Question: In one sentence, what is this figure communicating?
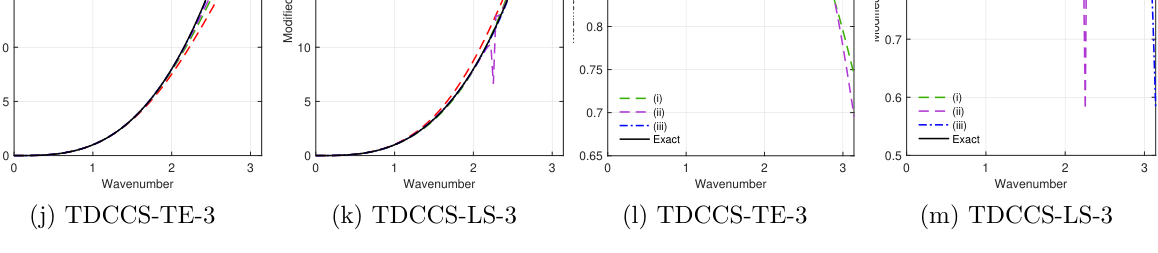
Answer: Plot of modified wavenumber versus wavenumber for (a) TDCCS-TE-1, (b) TDCCS-LS-1, (e) TDCCS-TE-2, (f) TDCCS-LS-2, (j) TDCCS-TE-3 and (k) TDCCS-LS-3: (i) T4; (ii) T6; (iii) T8; (iv) P10. Variations of the relative modified wavenumber factor Rω′′′ with wavenumber for (c) TDCCS-TE-1, (d) TDCCS-LS-1, (g) TDCCS-TE-2, (h) TDCCS- LS-2, (l) TDCCS-TE-3 and (m) TDCCS-LS-3:(i) T6; (ii) T8; (iii) P10.